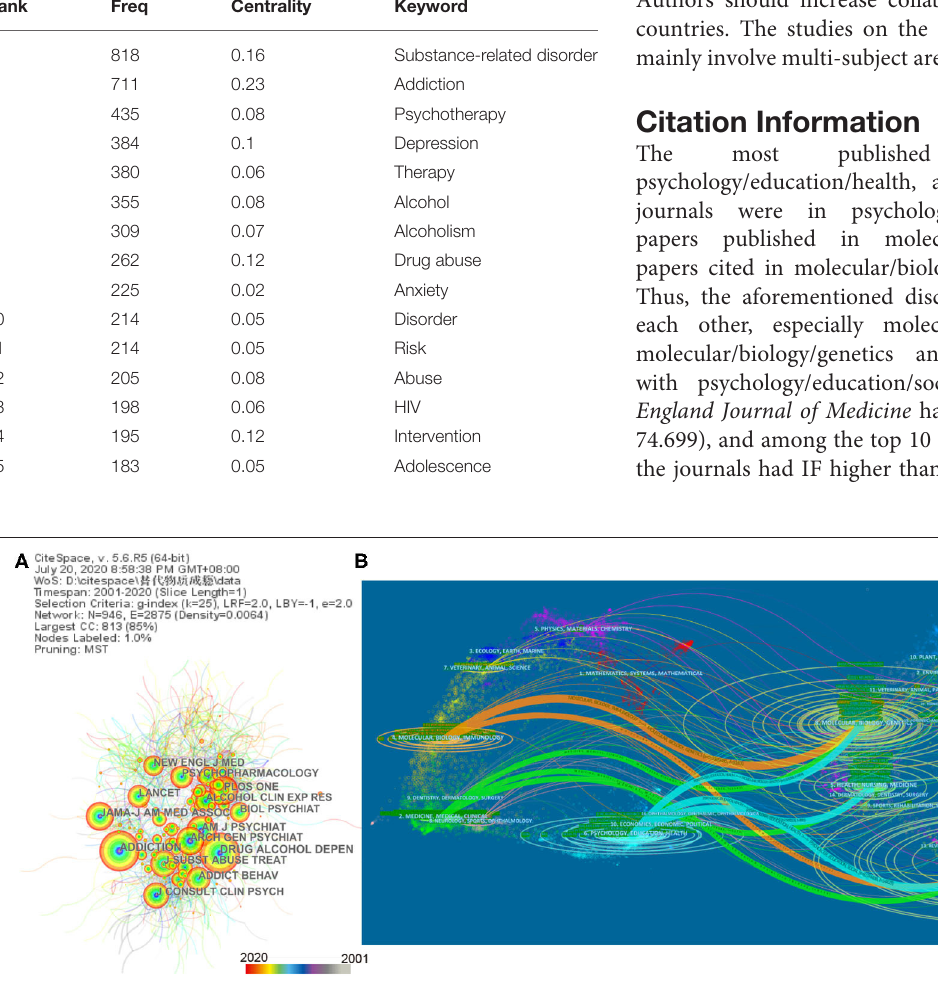
FIGURE 6 | Network map and dual map of cited journals for complementary and alternative medicine (CAM) for substance use disorders (SUDs). (A) Network map and dual map of the cited journals for CAM for SUDs (top 15 results). A total of 944 journals were cited, with 946 nodes and 2,875 links. Time slice on 1 year, and different colors present different years as the legend shows. The nodes consist of an annual ring by different colors as the legend, and the thickness of the annual ring represents the number of research published on the journal at the corresponding time. (B) A dual map of journals of published papers. Lines indicate cross studies between disciplines, and the thickness of the lines indicates close connections. The orange path: Papers published in molecular/biology/immunology, mostly cited journals in molecular/biology/genetics and psychology/education/social. The green and blue paths: Papers published in medicine/medical/clinical journals and psychology/education/health journals mostly cited in molecular/biology/genetics, psychology/education/social, and